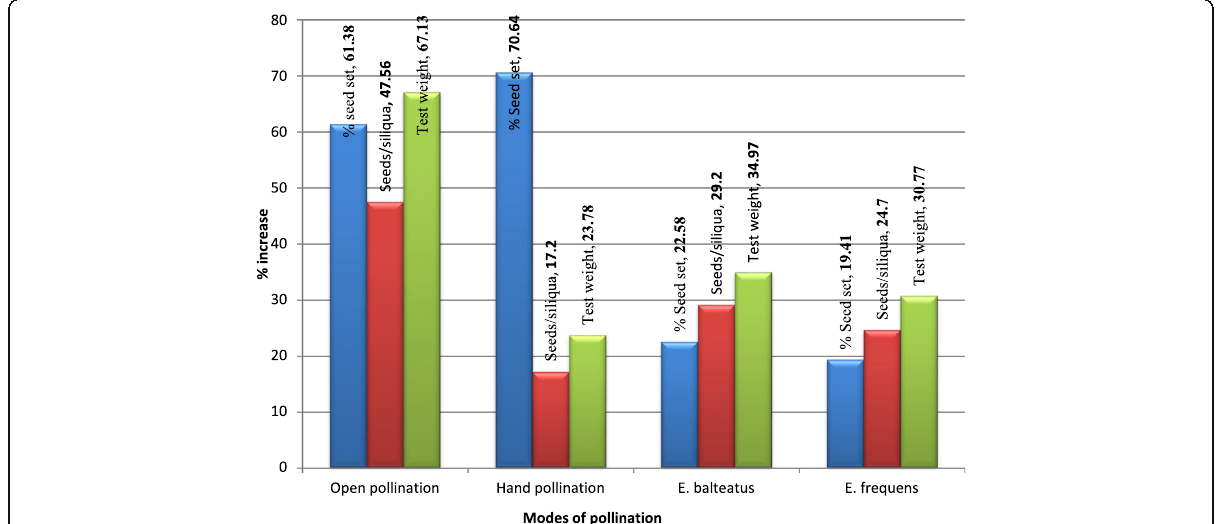
Fig. 2 Percent increase in seed set, seed/siliqua, and test weight in comparison to pollinator exclusion cage. This data shows the percent increase in comparison to pollinator exclusion cage by using different modes of pollination using general formula, T − c/c × 100. Here, T = value of treatment and c = value in